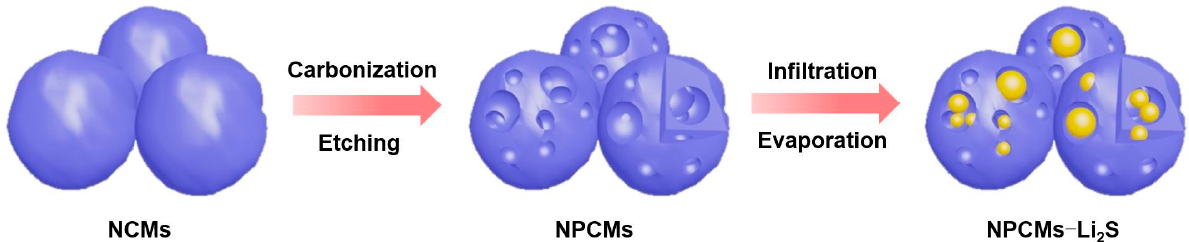
Figure 1. Illustration of synthesis process of NPCMs–Li 2 S composite.